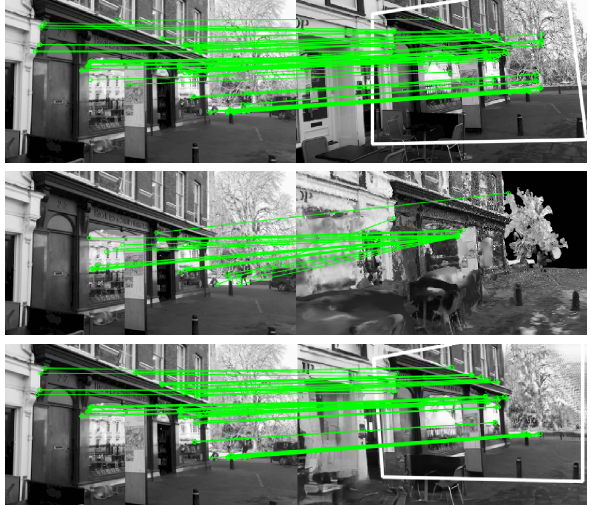
Figure 6. Visual example results for feature matching. Each row shows matched features between a captured image (left) and a training image (right). The white bounding boxes depict the boarders of the projected test images. Training images are from top to bottom in the captured , rendered and translated domain.